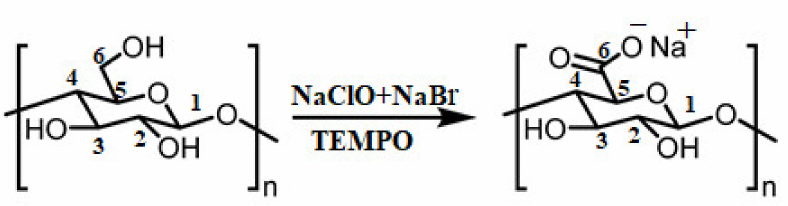
Figure 7. The most-applied approach of TEMPO-mediated oxidation of cellulose primary hydroxyl group to carboxyl groups.